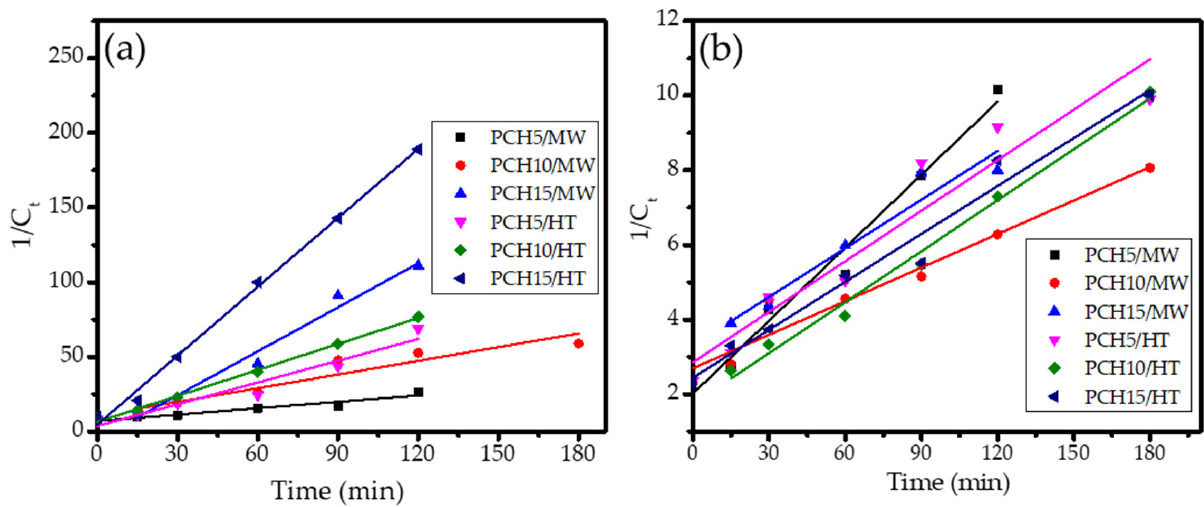
Figure 10. Pseudo-second-order plots of MV photodegradation over various ZnO/SiO 2 -PCH samples under ( a ) UV light; Figure 10. Pseudo ‐ second ‐ order plots of MV photodegradation over various ZnO/SiO 2 ‐ PCH samples under ( a ) UV light; ( b ) visible ( b ) visible light.